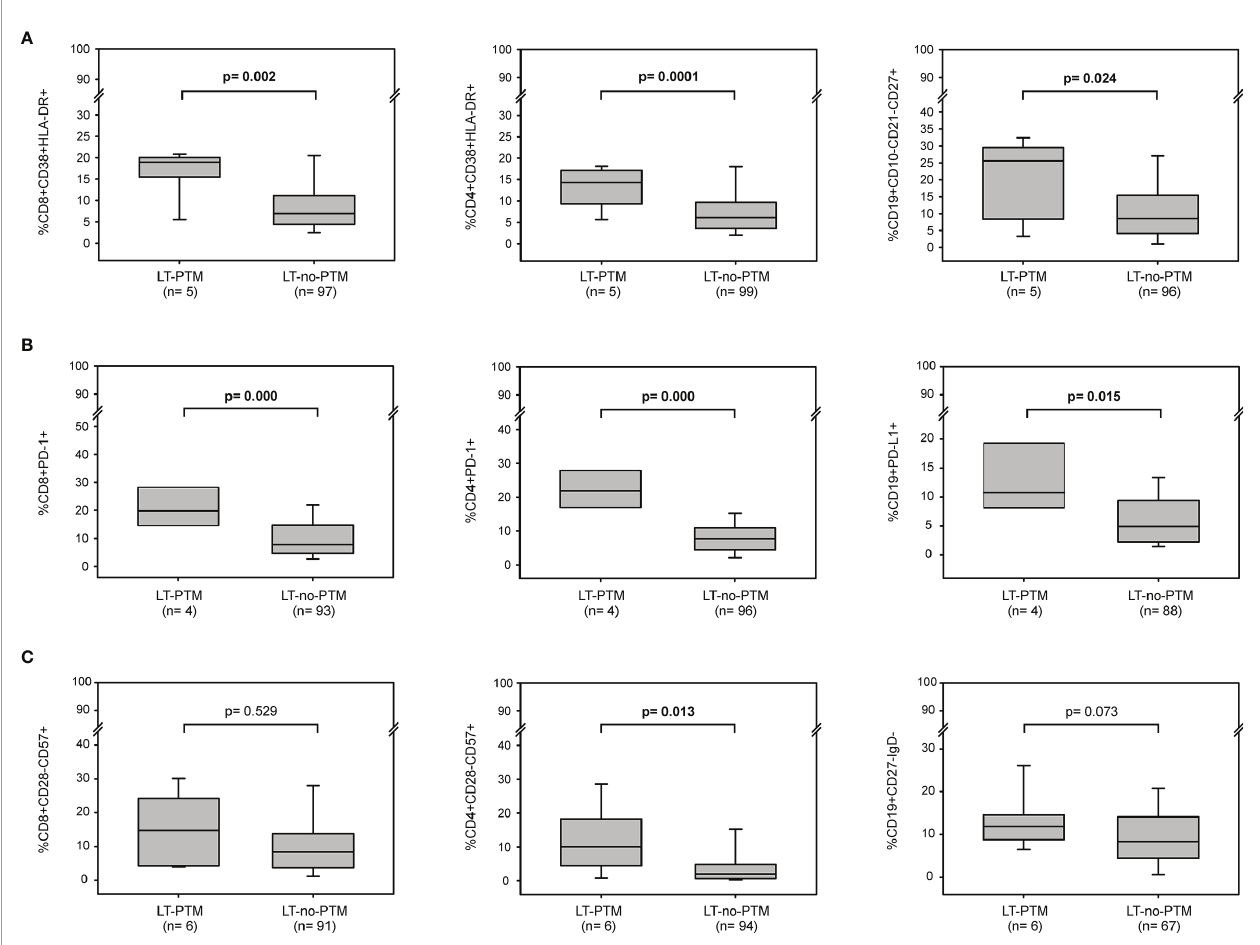
FIGURE 2 | Baseline immune activation, exhaustion and senescence pro fi les in LT-PTM and LT-no-PTM patients. Percentages of (A) activated CD8 + (CD3 + CD8 + CD38 + HLA-DR + ), CD4 + (CD3 + CD4 + CD38 + HLA-DR + ) and memory B (CD19 + CD10 - CD21 - CD27 + ) cells; (B) exhausted CD8 + (CD3 + CD8 + PD-1 + ), CD4 + (CD3 + CD4 + PD-1 + ) and B (CD19 + PD-L1 + ) cells, (C) senescent-like CD8 + (CD3 + CD8 + CD28 - CD57 + ), CD4 + (CD3 + CD4 + CD28 - CD57 + ), and B (CD19 + CD27 - IgD - ) cells in LT-PTM and LT-no-PTM patients. All p-values were adjusted by